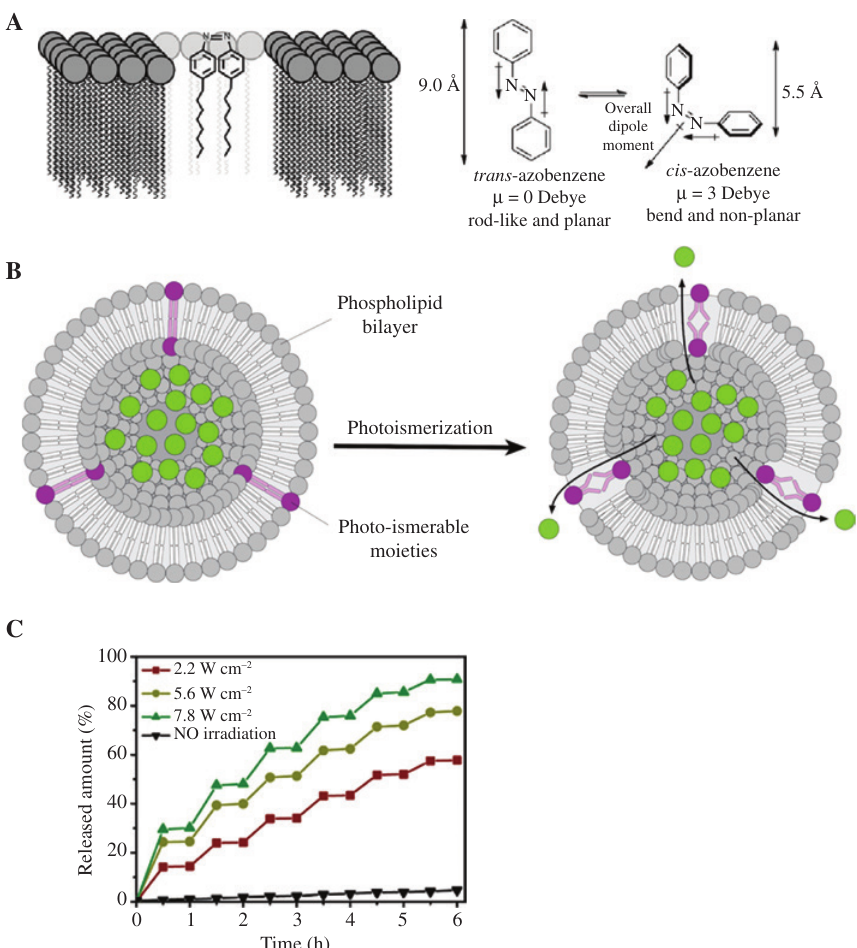
Figure 4: Light-sensitive liposomes via cis-trans isomerization of azobenzene. (A) Schematic of a liposomal membrane equipped with azobenzene moieties (left), and the polarity alterations during the reversible cis-trans isomerization of azobenzene (right) [85] (open access). (B) Schematic of photo-isomerization mechanism that occurred in liposomal carriers. (C) Drug release curves under 980-nm irradia- tion (Release obtained in buffer and under the irradiation duration time of 30 min). Reprinted with permission from Ref. [86], copyright 2016, John Wiley & Sons,